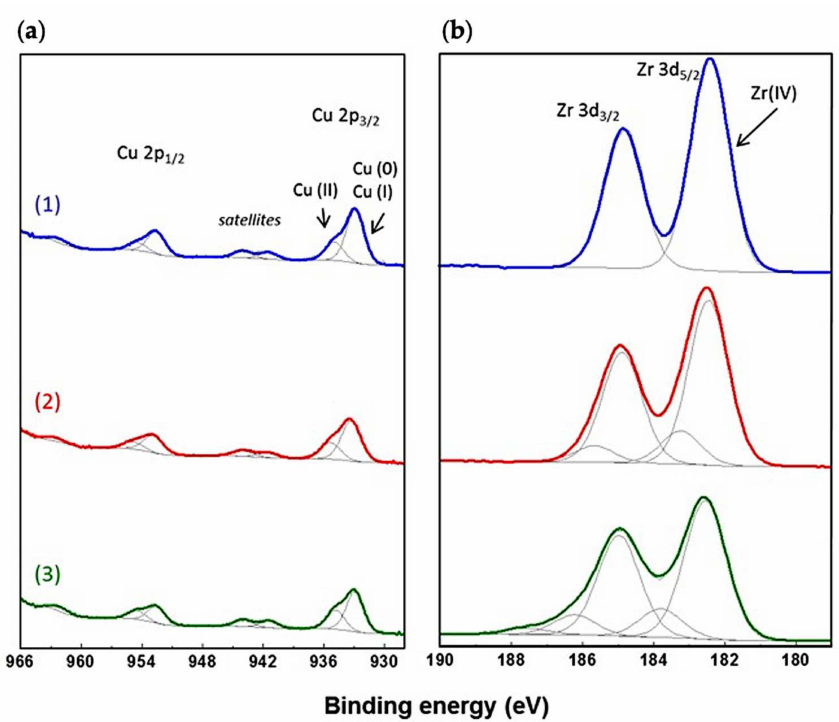
Figure 4. High-resolution XPS spectra of the Cu 2p ( a ) and Zr 3d ( b ). ( 1 ) Cu NPs/ZrO 2 pH = 4, ( 2 ) Cu NPs/ZrO 2 pH = 7, ( 3 ) Cu NPs/ZrO 2 pH = 9.